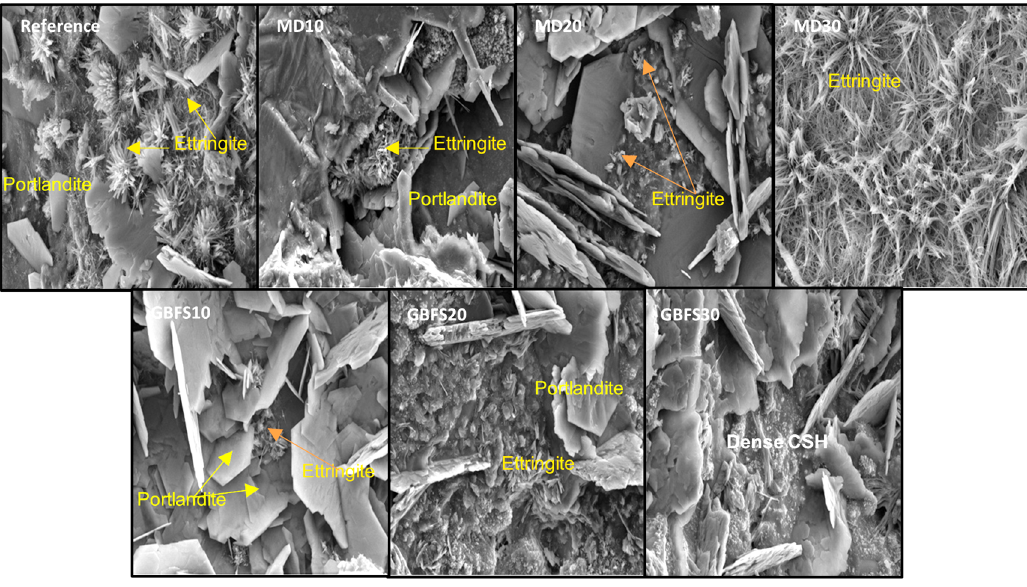
Figure 11. Microstructure of the SCC specimens after sulfate effect.